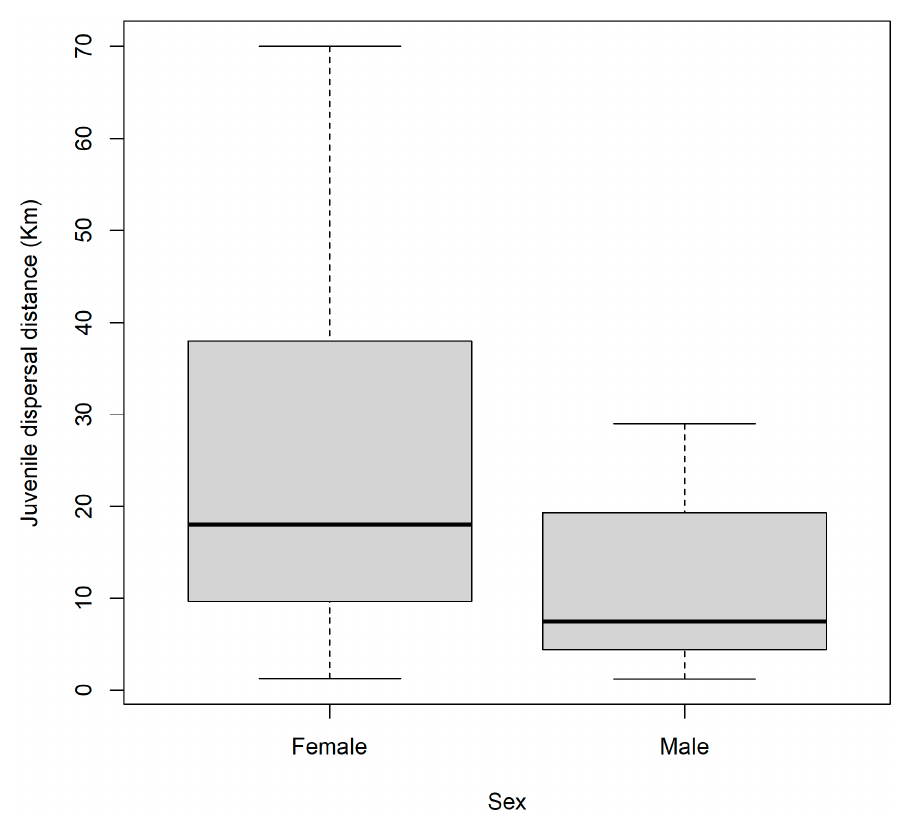
Figure 3. Boxplot for juvenile dispersal distance (km) of male and female Black-shouldered Kites ( Elanus caeruleus ) monitored in southwestern Spain. Horizontal lines = median and boxes are inter- quartile range. Sample size is 30 males and 17 females.